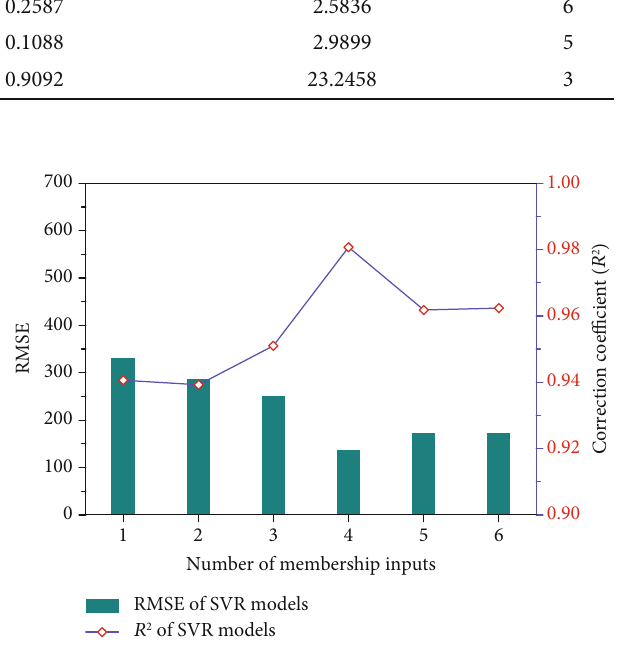
Figure 3: Comparison of the RMSE and correlation coe ffi cient ( R 2 ) for the SVR models with di ff erent numbers of membership